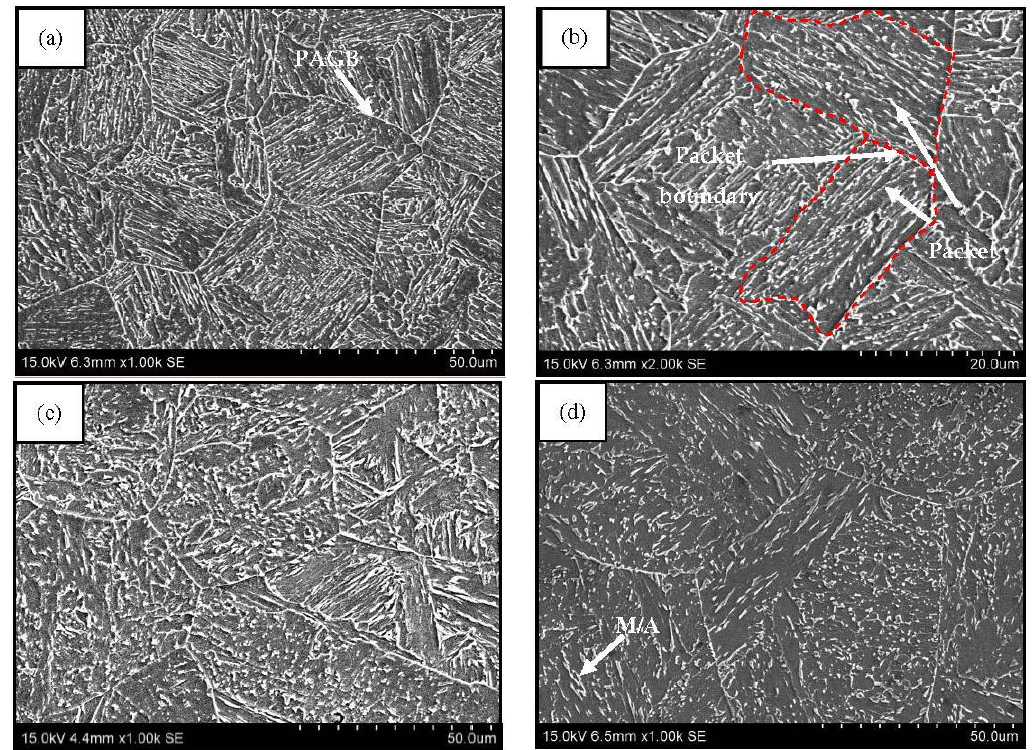
Figure 4. SEM images of the specimens with different heat inputs: ( a , b ) 30 kJ/cm; ( c ) 40 kJ/cm; ( d ) 60 kJ/cm. PAGB—prior austenite grain boundary and M/A—martensite/austenite.